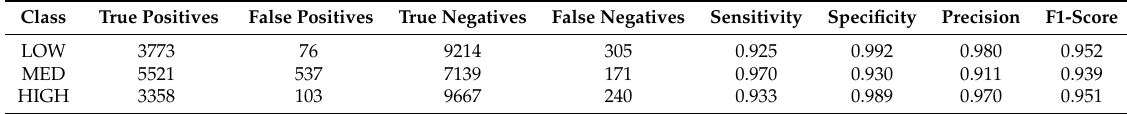
Table 12. Additional metrics obtained for Valence (Train) classification with the GSR + ECG system. Class